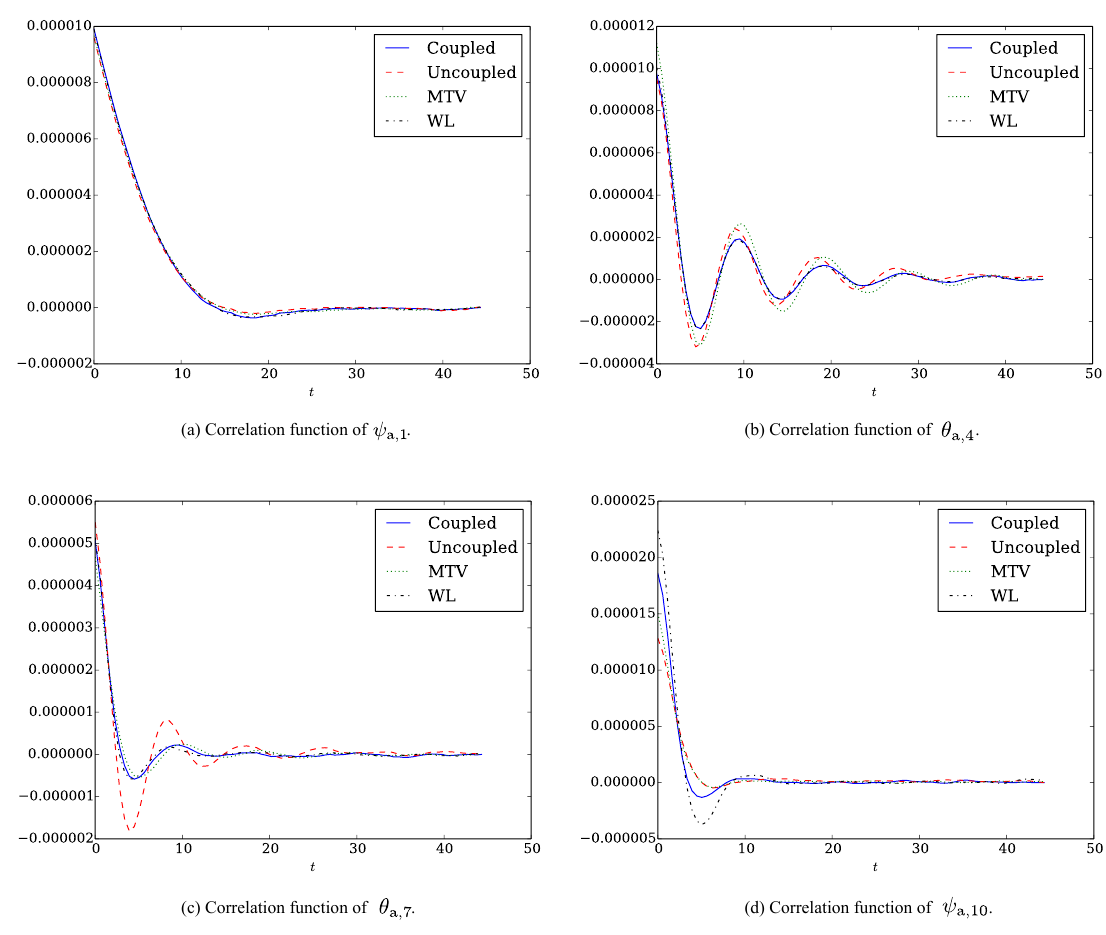
Figure 9. Correlation function of various variables for the wavenumber 2 parameterization and with the parameter set DV2017. The corre- lation of the full coupled system (13), the uncoupled system, and the MTV and the WL parameterizations are depicted as a function of the time lag t (in